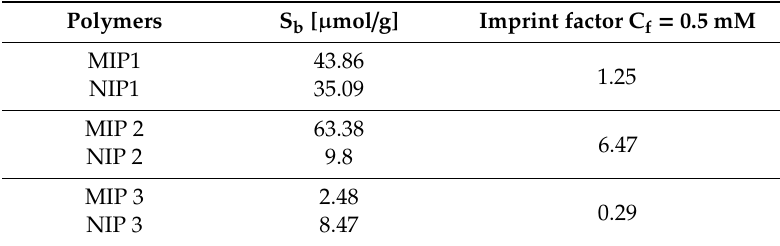
Table 2. The amount of binding for MIP and Non-Imprinted Polymer (NIP) at C f = 0.5 mM. Polymers